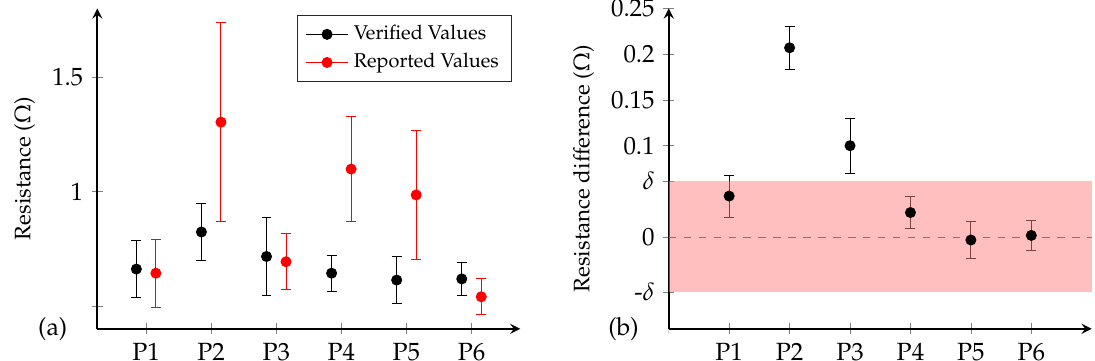
Figure 4. ( a ) Participant-reported and expert-verified resistance of the hand-sewn electrodes (HSE) from each participant; and ( b ) equivalence test comparing the set of electrodes of each participant with the set of MSE. Note: (1) The mean and standard deviation of resistance values over 10 repeated measurements on each of the 10 electrodes created during the workshop. (2) The difference between the mean resistance value of the HSE and that of the MSE (mid-section of the bar) for each participant. The extremities of the bars represent the lower and higher value of the confidence interval. The pink shaded area indicates the extent of the equivalence